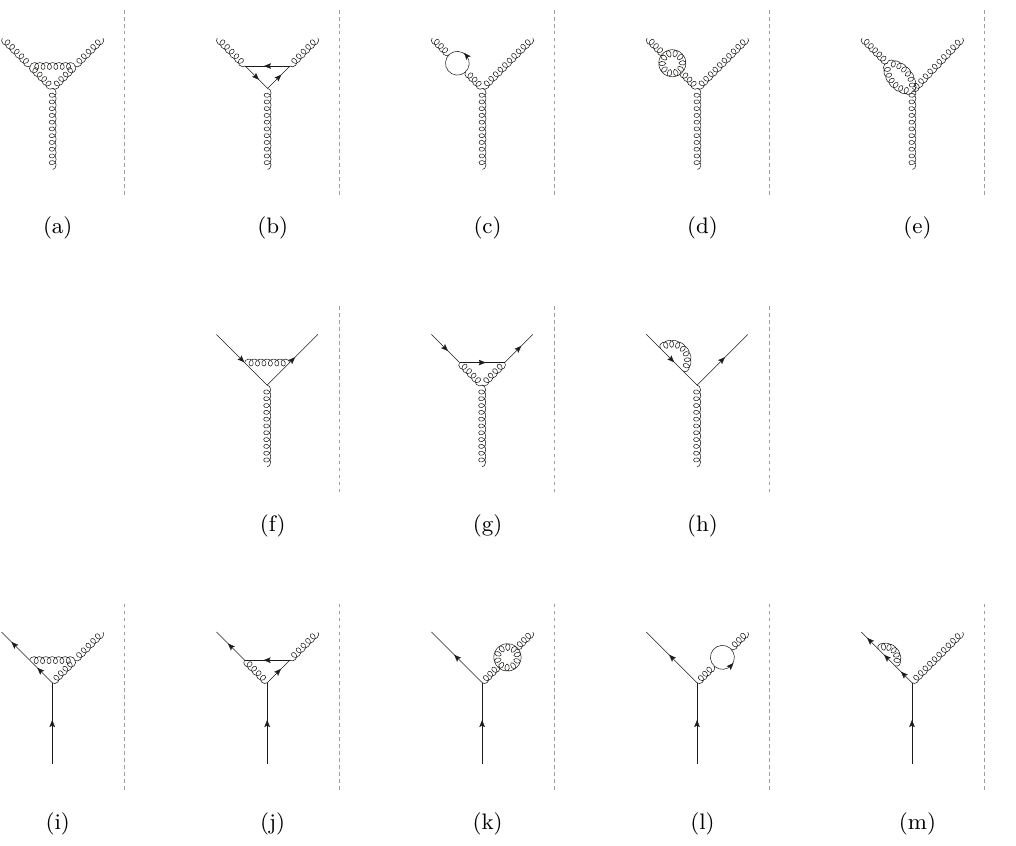
Figure 5 . Virtual graphs for the amplitude in LO channels. The tree graphs in the complex conjugate amplitude are not shown. In Feynman gauge, there is an additional graph with Faddeev- Popov ghosts for each graph with a closed gluon loop.